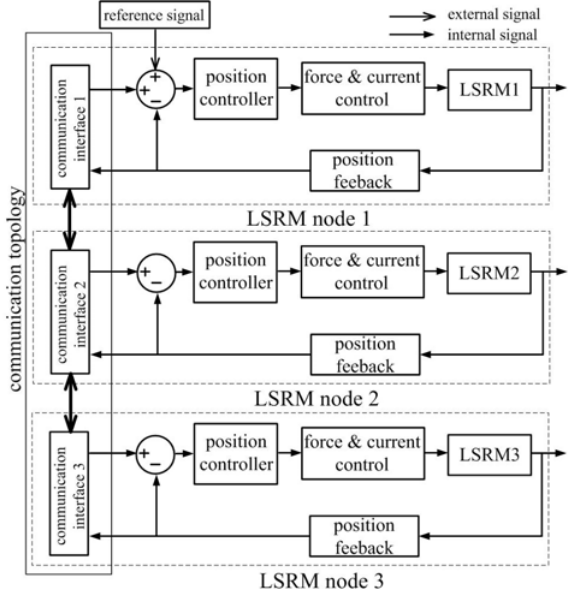
Figure 3. LSRM network hardware frame.